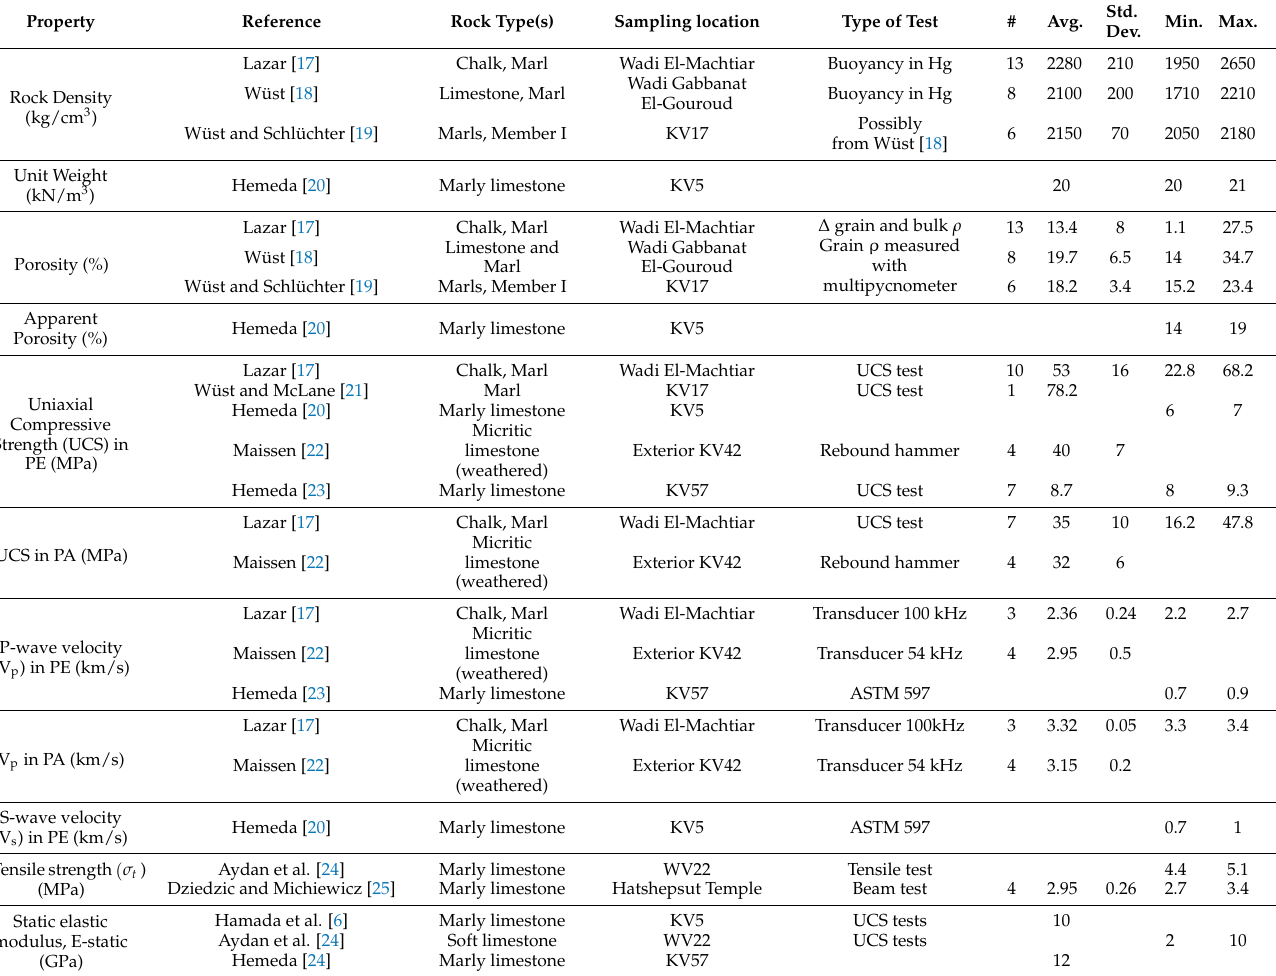
Table 1. Summary of reported values of geotechnical properties of rock units present in the Theban Necropolis. Where values or factual information are not explicitly reported a blank entry is left in the table. WV stands for West Valley of the Kings, whilst KV symbolises the East Valley of the Kings. KV# refers to a tomb within KV (e.g., KV17 is tomb 17). Wadi el-Machtiar and Wadi Gabbanat El-Gouroud are gullies near the KV within the Theban Necropolis, but they are not archaeological sites. These gullies’ locations are shown in Figure 1. #: number of samples: Avg.: average; Std. Dev.: standard deviation; Min.: minimum; Max.: maximum; ∆ : differences; ρ : density. PA and PE denote the orientation of tests with respect to bedding